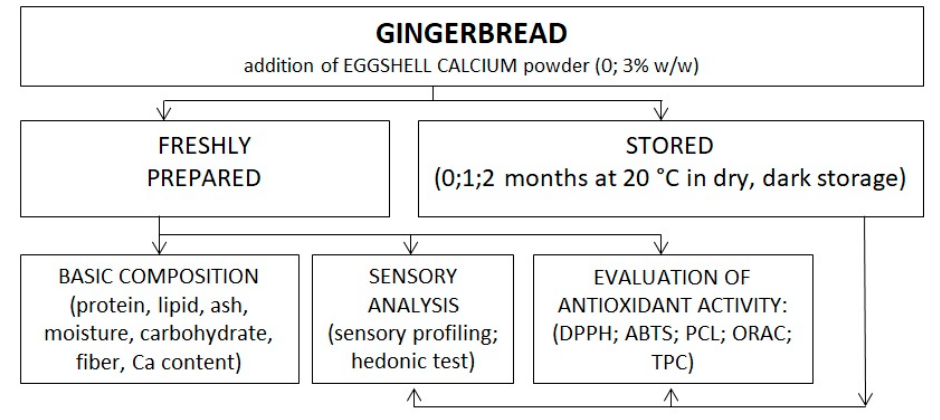
Figure 3. The research scheme